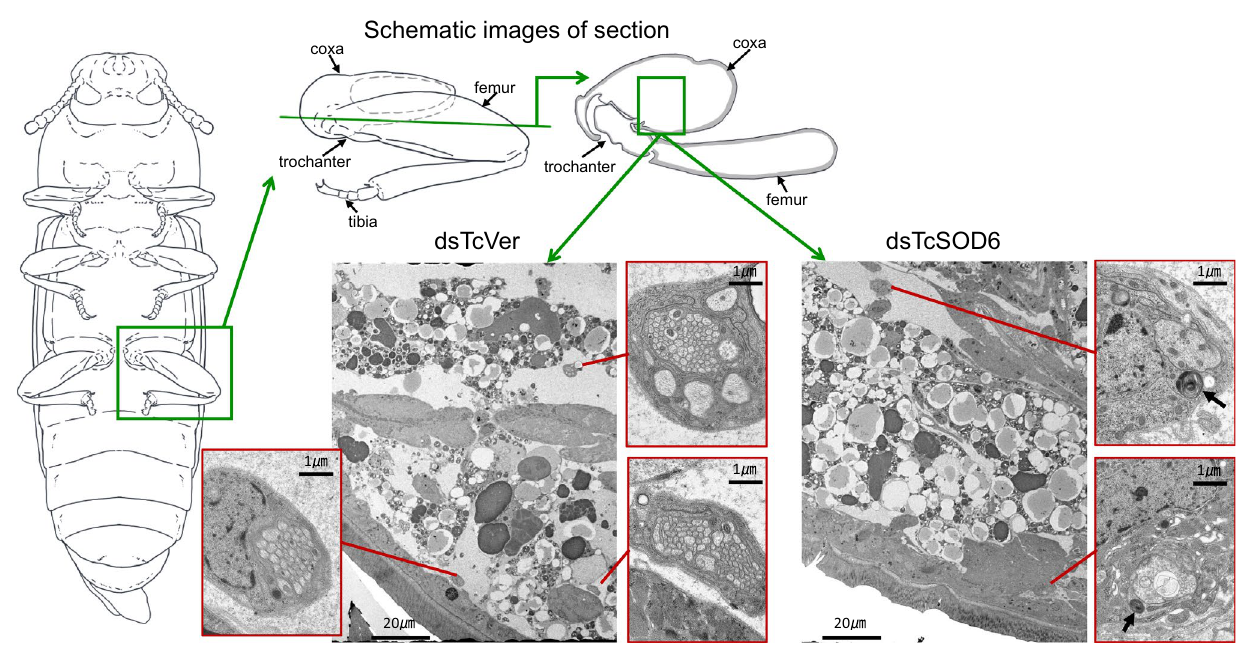
Figure 8. Ultrastructural images of coxa in TcVer- and TcSOD6 -knockdown-hind legs. Representative transmission electron microscopy images obtained from day 6 pupae in the TcVer - and TcSOD6 -knockdown groups. The positions of T. castaneum adult legs are shown in illustrations. The left panel shows a TcVer - knockdown pupa. Right panels show a TcSOD6 -knockdown pupa. The inclusion bodies are indicated by a black arrow. The high magnification images are shown by the red boxes. Bar = 1 µm or 20